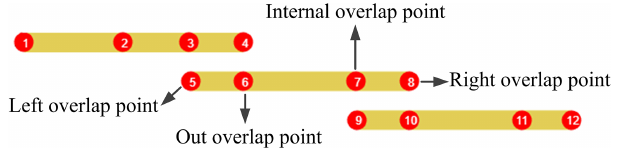
Figure 4. Overlap point of boom sections.